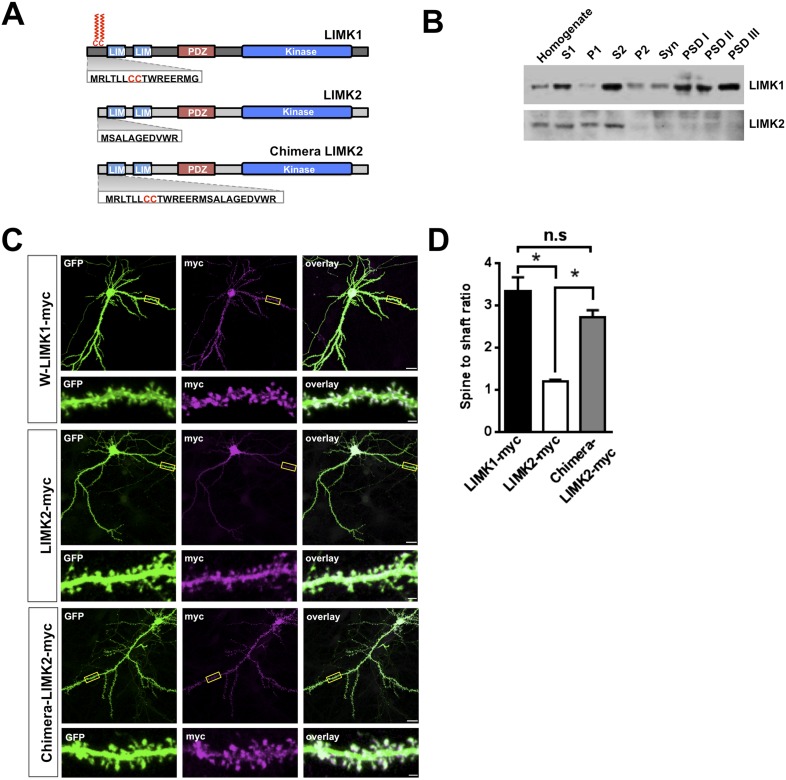
LIMK1's palmitoyl-motif accounts for differential localization of LIMK1 and LIMK2.(A) Schematic of LIMK1 (top) and LIMK2 (middle), showing similar overall domain arrangement. Rat LIMK1 and LIMK2 kinase domains are 70% identical, 84% similar (NCBI BLAST). Expanded N-terminal sequences show LIMK1's unique CC motif. Lower schematic shows a chimeric protein in which the N-terminal 15 amino acids of LIMK1 are fused to LIMK2 (‘Chimera LIMK2’). (B) The indicated rat forebrain subcellular fractions were blotted to detect endogenous LIMK1 and LIMK2. LIMK1 is seen in Post-synaptic Density (PSD) fractions, consistent with a previous study, but LIMK2 is not. Fidelity of the preparation and antibody specificity is confirmed in Figure 3—figure supplement 1. (C) Hippocampal neurons (DIV18) were transfected to express GFP plus the indicated myc-tagged LIMK variants. Representative images of single neurons immunostained with the indicated antibodies are shown (scale bar: 20 μm). Lower panels show magnified images of single dendrites. (D) Spine targeting ratio (mean ± SEM) for n = 30 neurons per condition from C. * p < 0.05; n.s.: p > 0.05, ANOVA with Dunnett's post hoc correction.